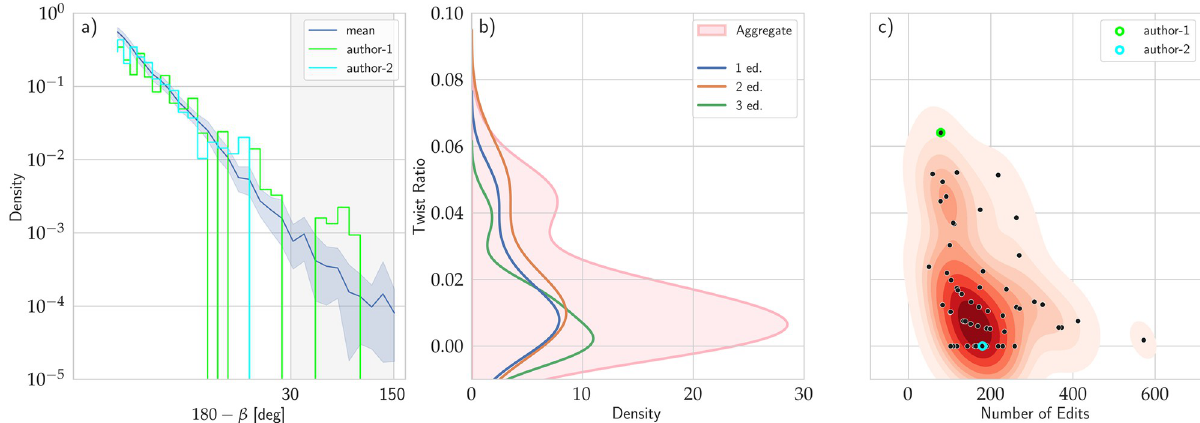
Fig 4. Twist ratio. (a) The distribution of the angle between consecutive velocities in the evolution of the draft. The area we have defined as exploratory is highlighted in gray. The dark blue line depicts the average distribution of the angle, while the pale blue area outlines the 99.5% confidence interval estimated using the bootstrap technique at each point. The light green and cyan lines show two example versions. (b) The distribution of the Twist Ratio over all workshops [pink] and the kernel density estimation for each workshop. (c) The distribution of the exploratory steps per draft compared to the number of edits for each workshop. The examples presented in the left panel are outlined in the corresponding color.